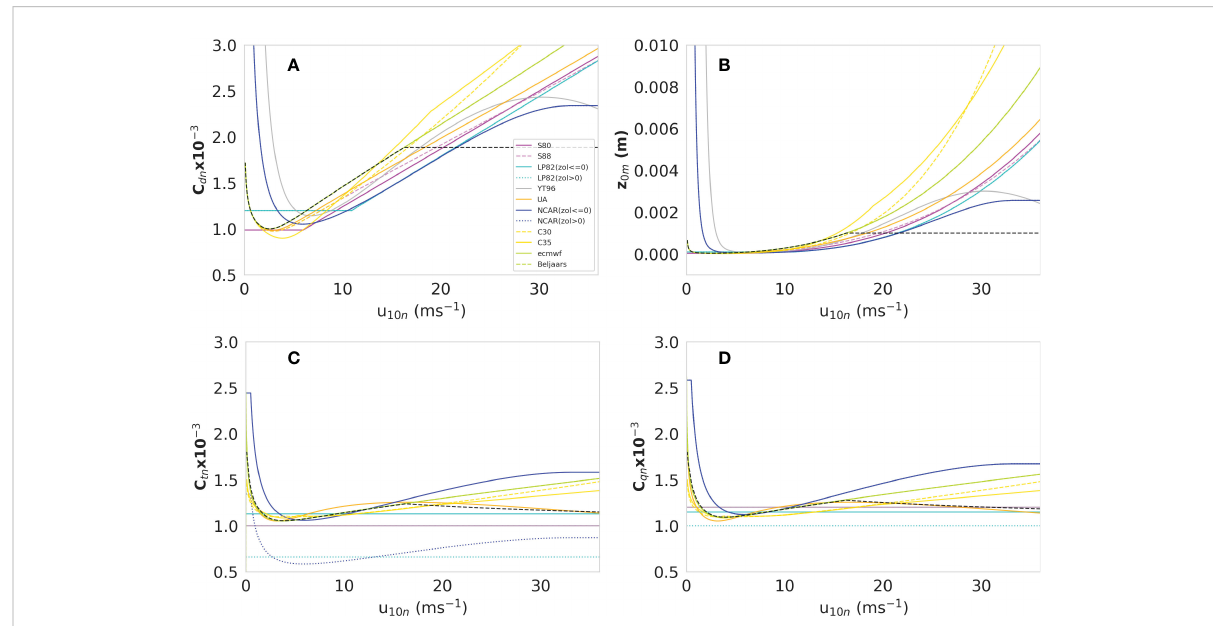
FIGURE 1 The ten bulk formulae parameterizations included in AirSeaFluxCode as given in the key and Table 1. The momentum fl ux parameterizations are given in terms of both (A) the drag coef fi cient at neutral stability and a reference height of 10 m, C d10n , and (B) momentum roughness length, z 0m , regardless of their original formulation (Tables 4, 5) for ease of comparison. Ten meter neutral transfer coef fi cients for the (C) sensible heat fl ux, C fi cients for the heat fl uxes fl ux, C t10n , and (D) the latent heat q10n are also shown. Note that LP82 and NCAR both provide different coef under stable/unstable atmospheric conditions (values for stable conditions are indicated with dotted lines). The dashed black lines show the ECMWF paramaterization as implemented in the Aerobulk code and demonstrates the effect of the limits placed on roughness lengths (these limits are not applied in the AirSeaFluxCode implementation of ECMWF, solid green line).